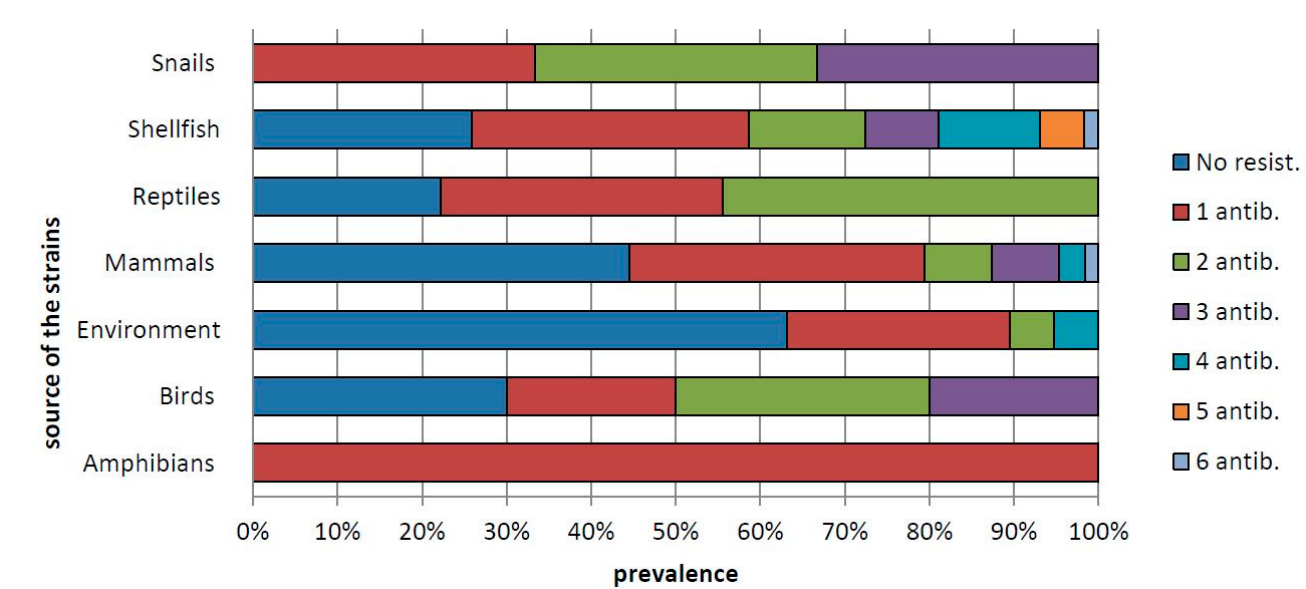
Figure 1. Percentage of Salmonella strains resistant to one or more (up to six) antibiotics in isolates from amphibians (frogs), birds, environment, mammals, shellfish, reptiles and snails.